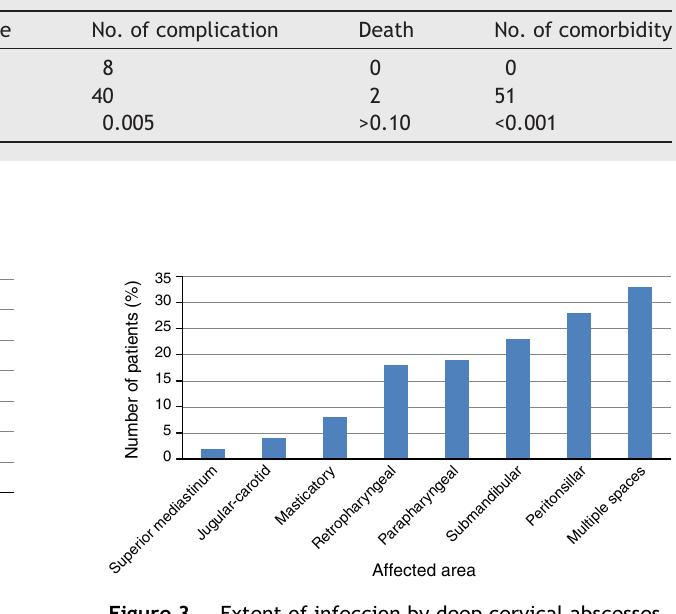
Etiology of deep cervical abscesses.